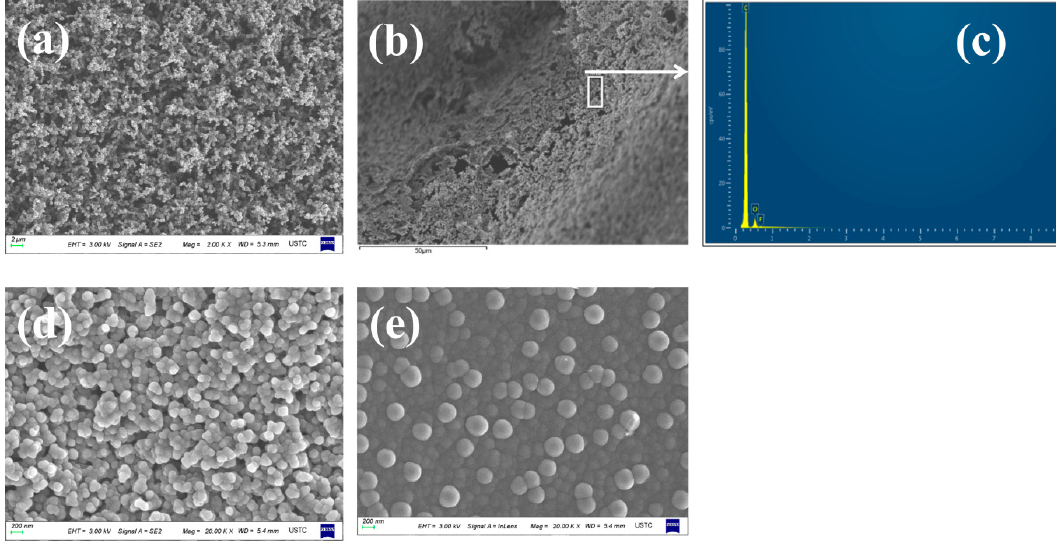
Figure 6. Carbon layer surface images at high magnification. (( a , b , d , e ): SEM; ( c ): EDS